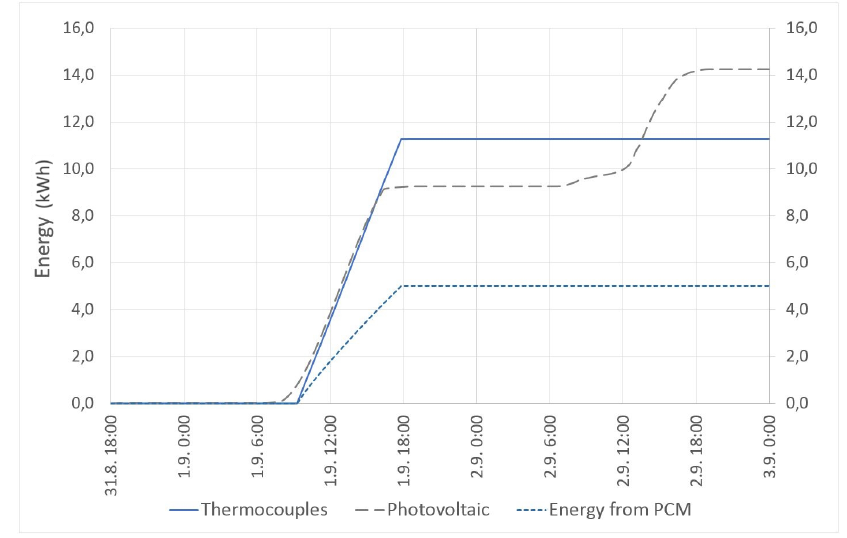
Figure 16. TEC energy consumption and energy production from renewable energy